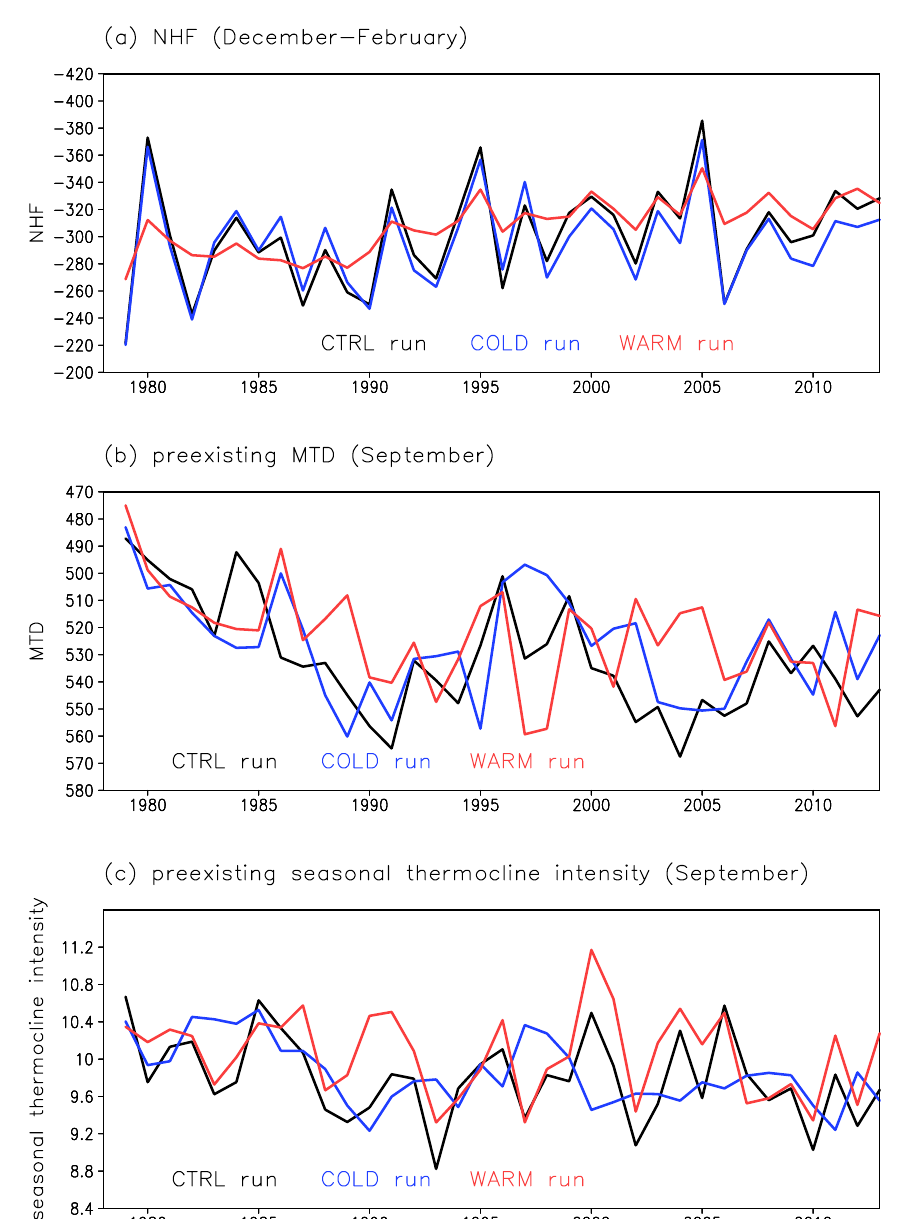
Figure 8. Temporal variations of the winter NHF, the preexisting MTD, and the preexisting seasonal thermocline intensity in the STMW formation region. ( a ) Mean NHF (negative values represent upward fluxes) (W m –2 ) for December–February, ( b ) MTD (m) in the preceding warm season (September), and ( c ) seasonal thermocline intensity (°C) in the preceding warm season (September) averaged in the STMW formation region. Black, blue, and red lines indicate the CTRL, COLD, and WARM runs, respectively. The MTD and seasonal thermocline intensity in the preceding warm season are plotted in the following year; e.g., the value in September 1999 is plotted in the year